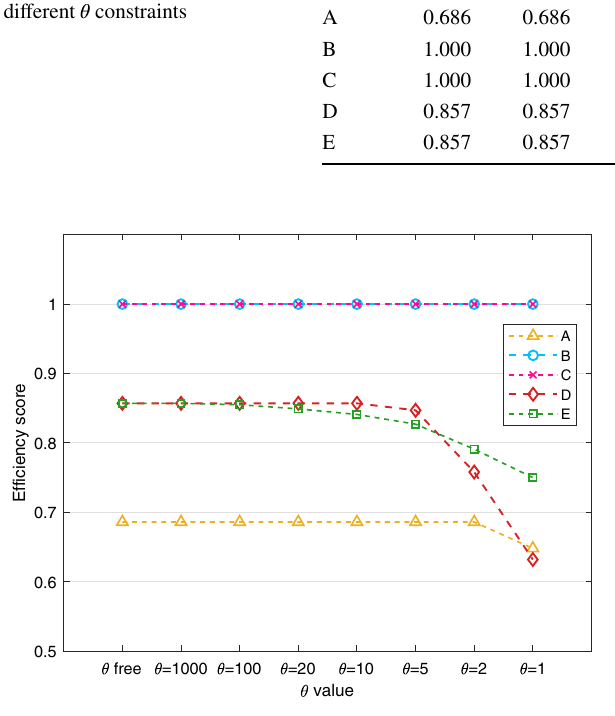
Table 7 Efficiency scores of the 2-CHCCR method with different 𝜃 constraints